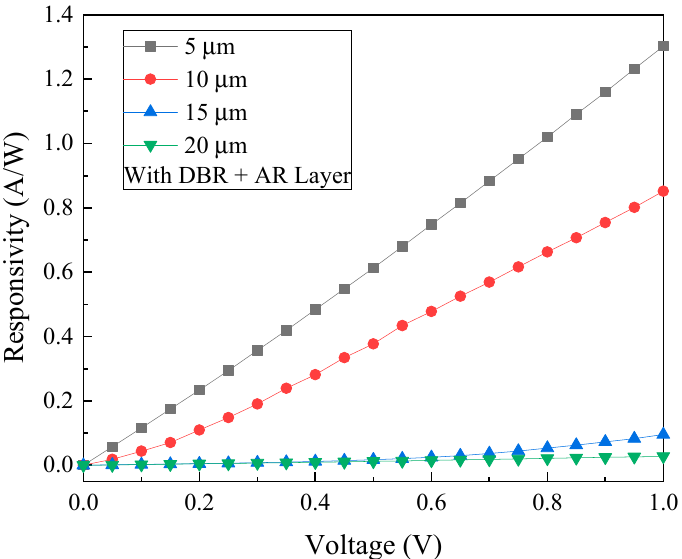
Figure 16. The responsivity of GeSn MSM PDs with combined AR layer and DBR structure, and with electrodes of four different sizes under 2000 nm illumination.